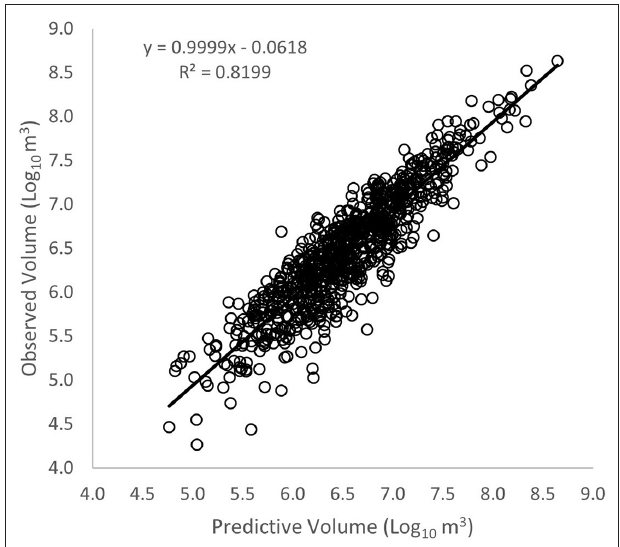
FIGURE 6 | Cael method of observed vs. predicted lake volumes for a linear regression model [ R 2 = 0.82, F (1,812) = 3,697, p < 2.2e − 16].